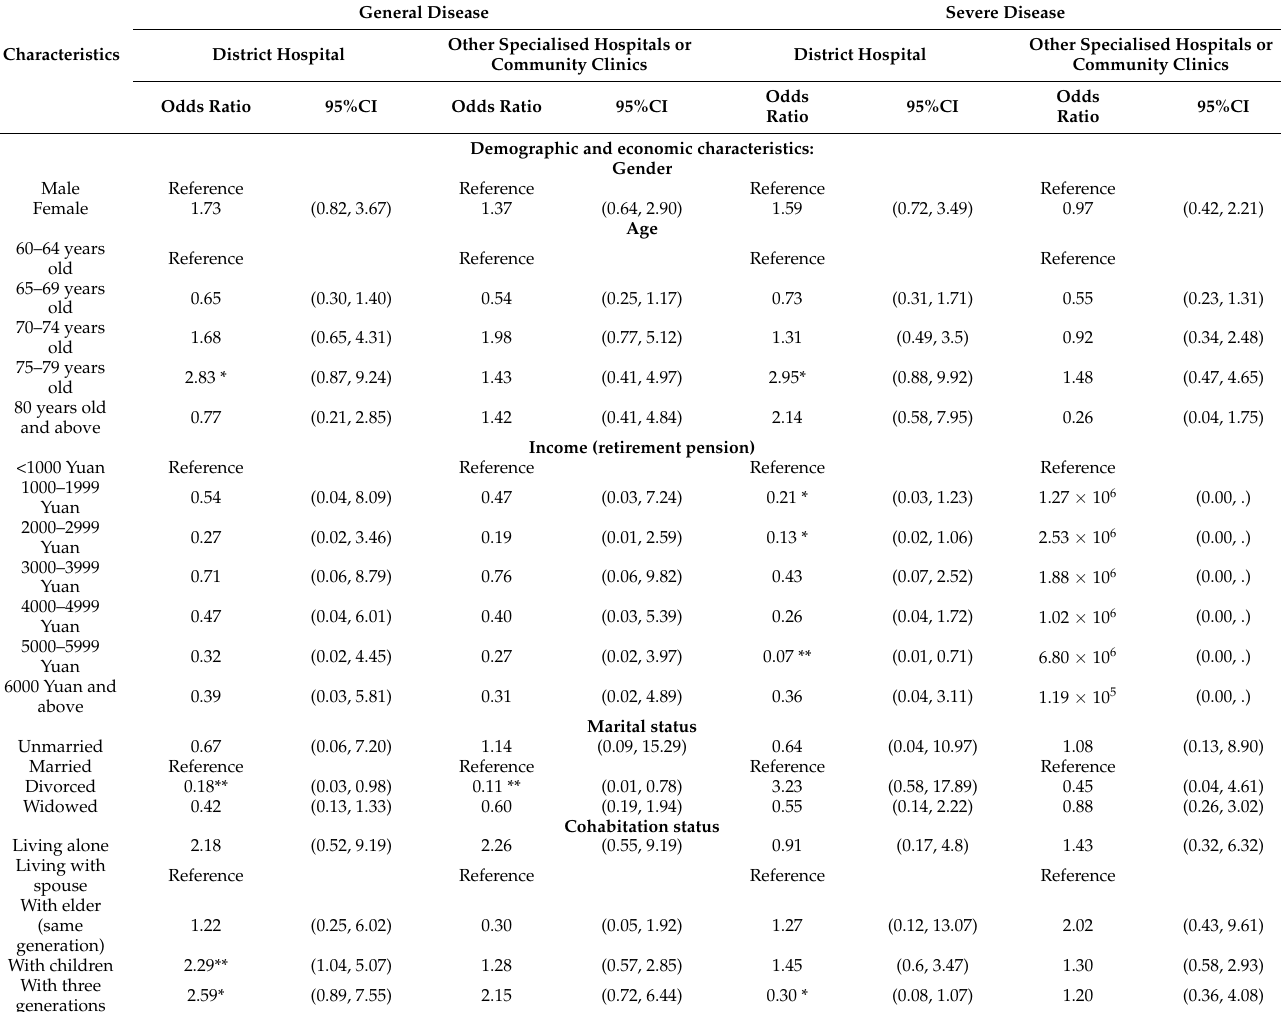
Table 3. Parameter estimation for medical institution choices of an elderly population with general disease (control group = general